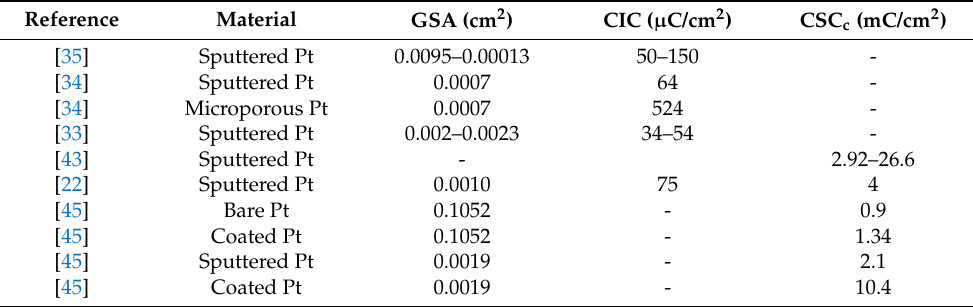
Table 5. Results from other